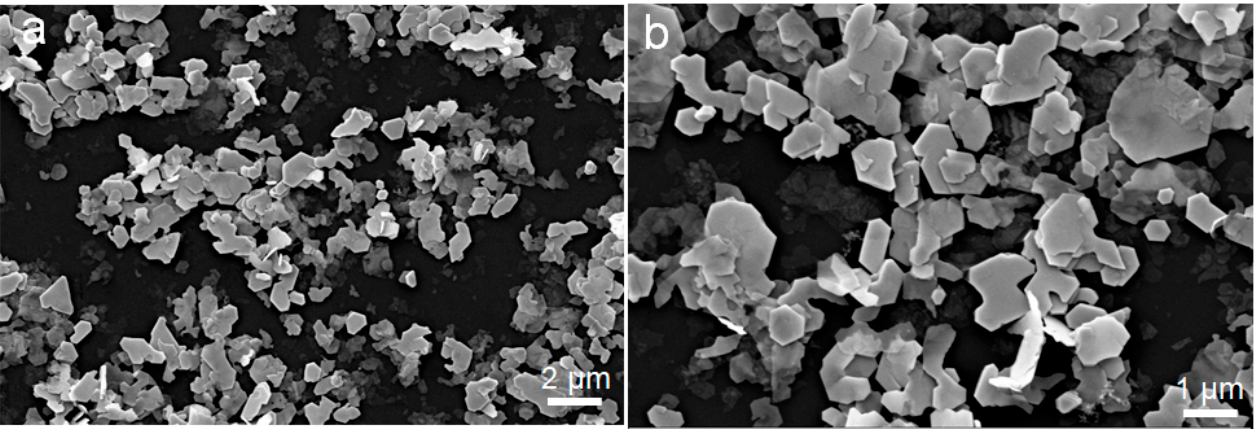
Figure 5. SEM micrographs of Bi 1.93 Sn 0.07 Se 3 nanosheets with different magnifications; ( a ) magnification 5.00 K × , ( b ) magnification 10.00 K ×.